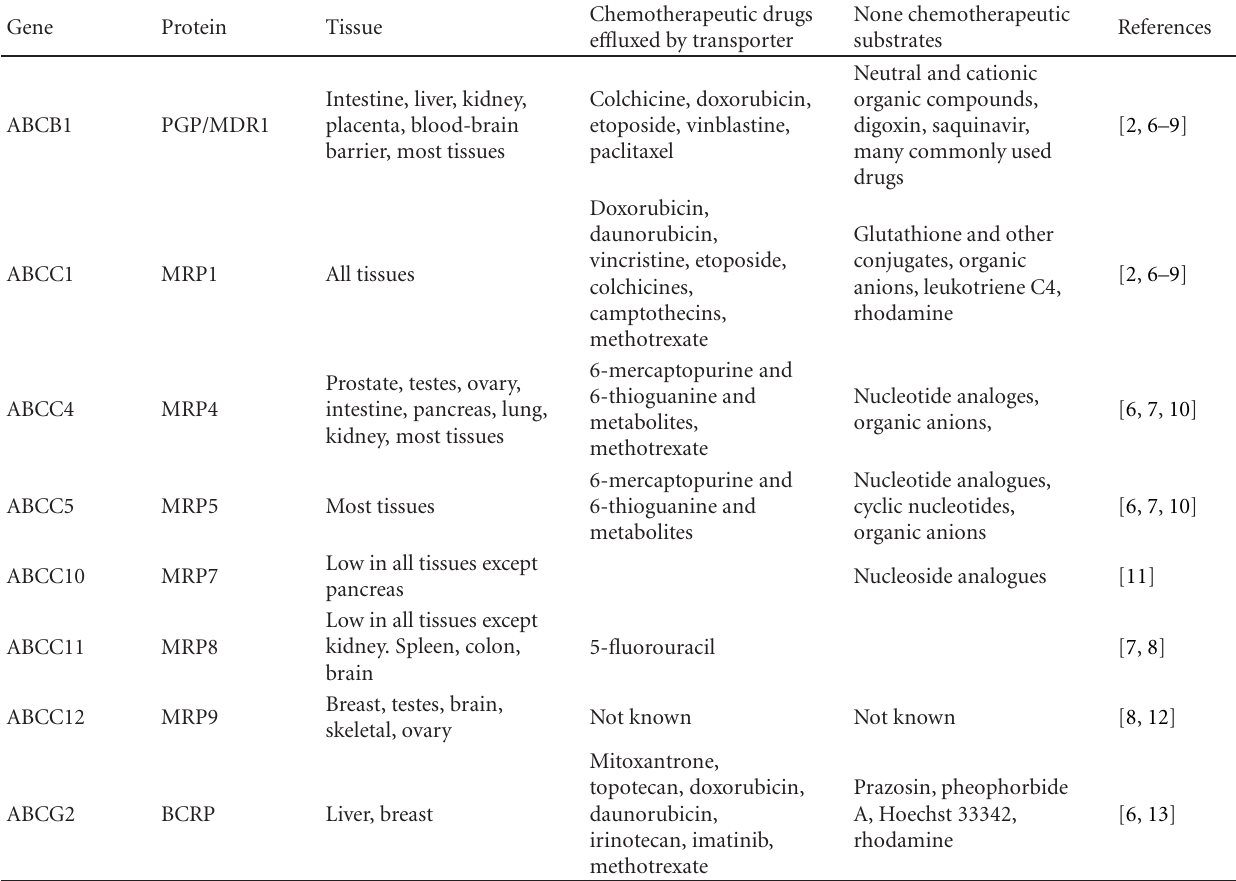
Table 1: The ABC transporters expressed in breast